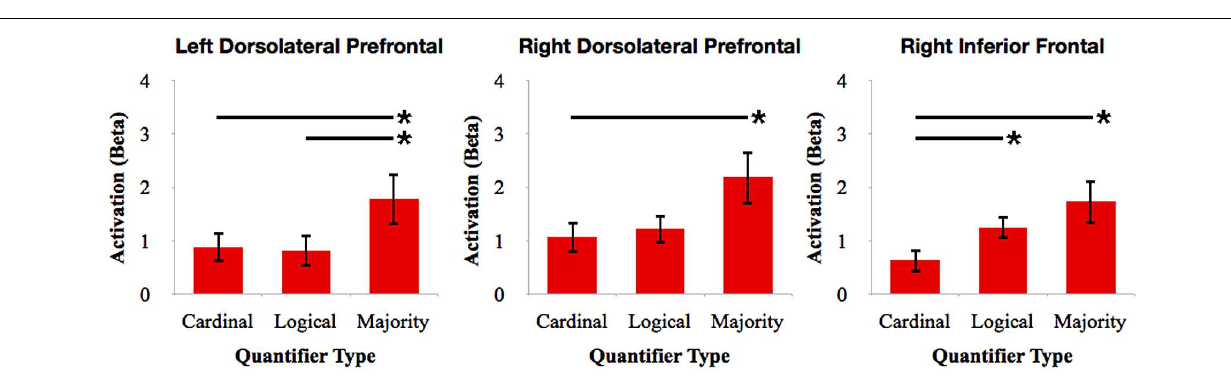
FIGURE 3 | Relative activation of each region of interest identified in the whole-brain analysis for each independent quantifier. Bars with asterisks (*) represent p < 0.05 Bonferroni-corrected.